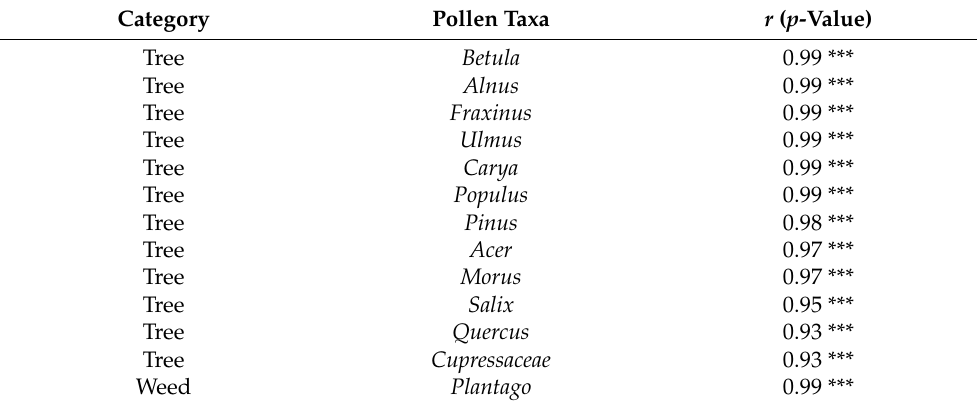
Figure 4. Time series plot and scatter plot of daily pollen concentration measured from the consistency test at the Southface site in 2021. *: multiplication. Table 2. Pearson Correlation of Matched Pollen Taxa (Southface1 vs.